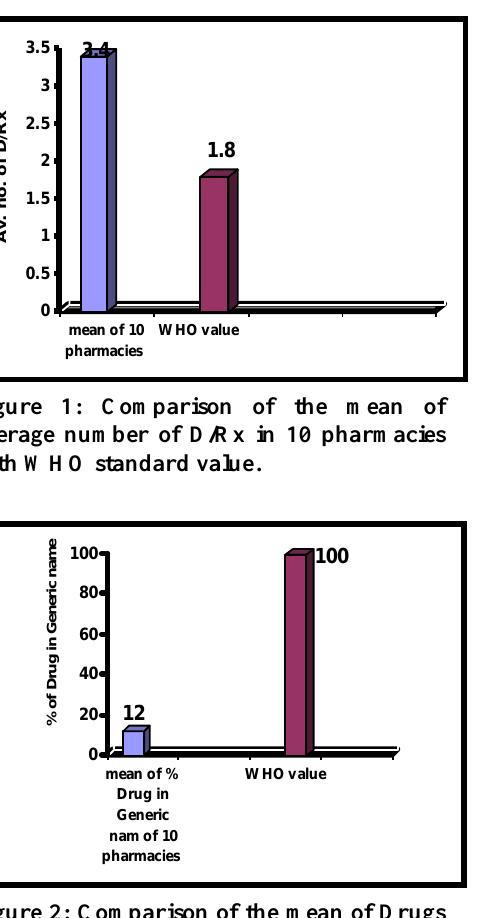
Figure 2: Comparison of the mean of Drugs in Generic name of 10 pharmacies with WHO standard value.